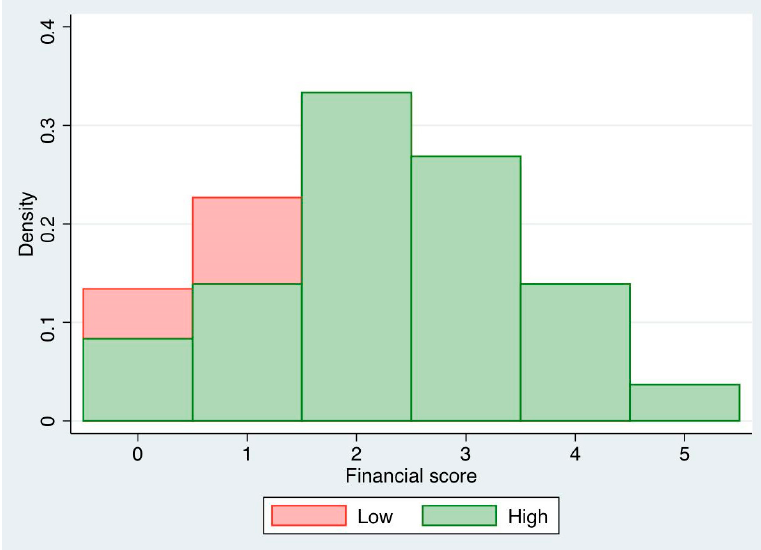
Figure A1 . Financial score by CRT score. Figure A1. Financial score by CRT